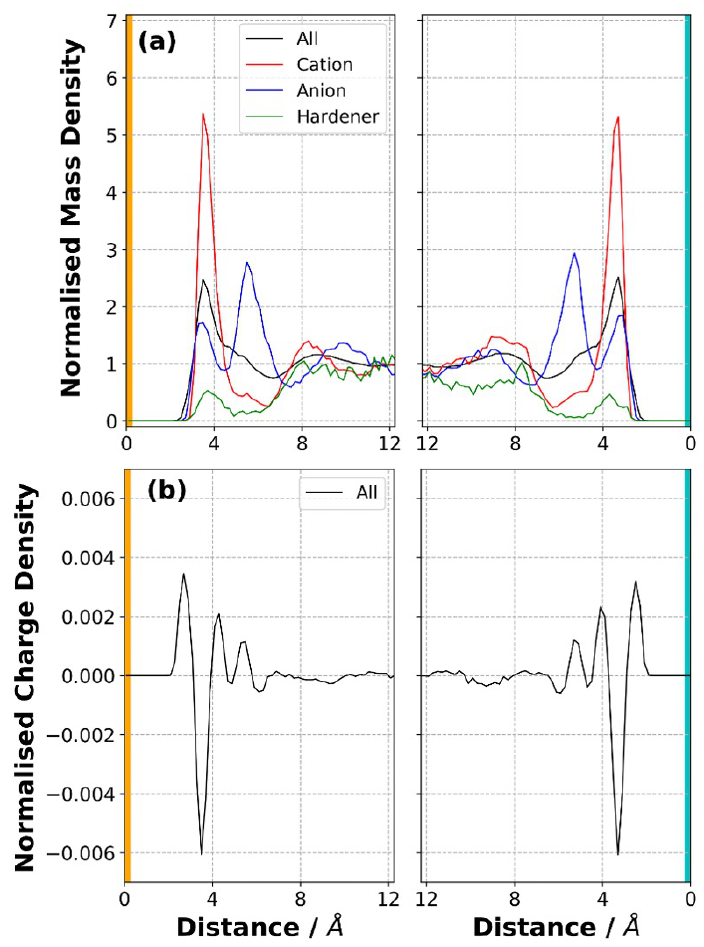
Figure 3. ( a ) Normalised mass density distribution for each component and ( b ) normalised overall charge density distribution near the negative (orange bar) and positive (cyan bar) electrodes obtained at the completion of the equilibration process of the liquid precursor mixture at 800 K. No potential difference was applied across the simulation